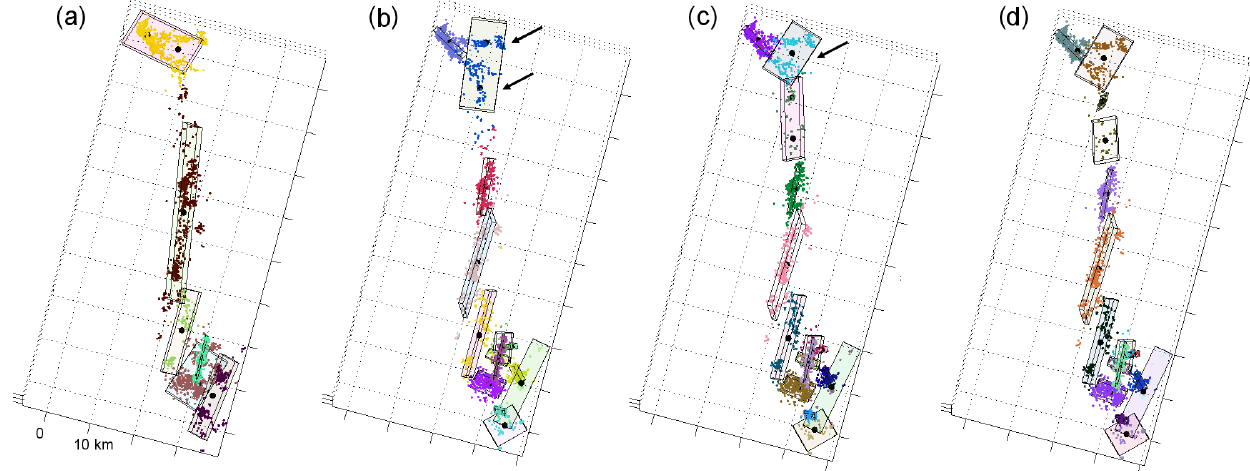
Figure 1. Iterative splits on the 1992 Landers aftershock data. Points with different colors represent seismicity associated with each plane. Black dots show the center points of the planes resulting from the next split. Notice how in steps (b) to (c) the planes fail to converge to the local branches (shown with arrows), and the method prefers to introduce a horizontal plane to fit a more complex local pattern.